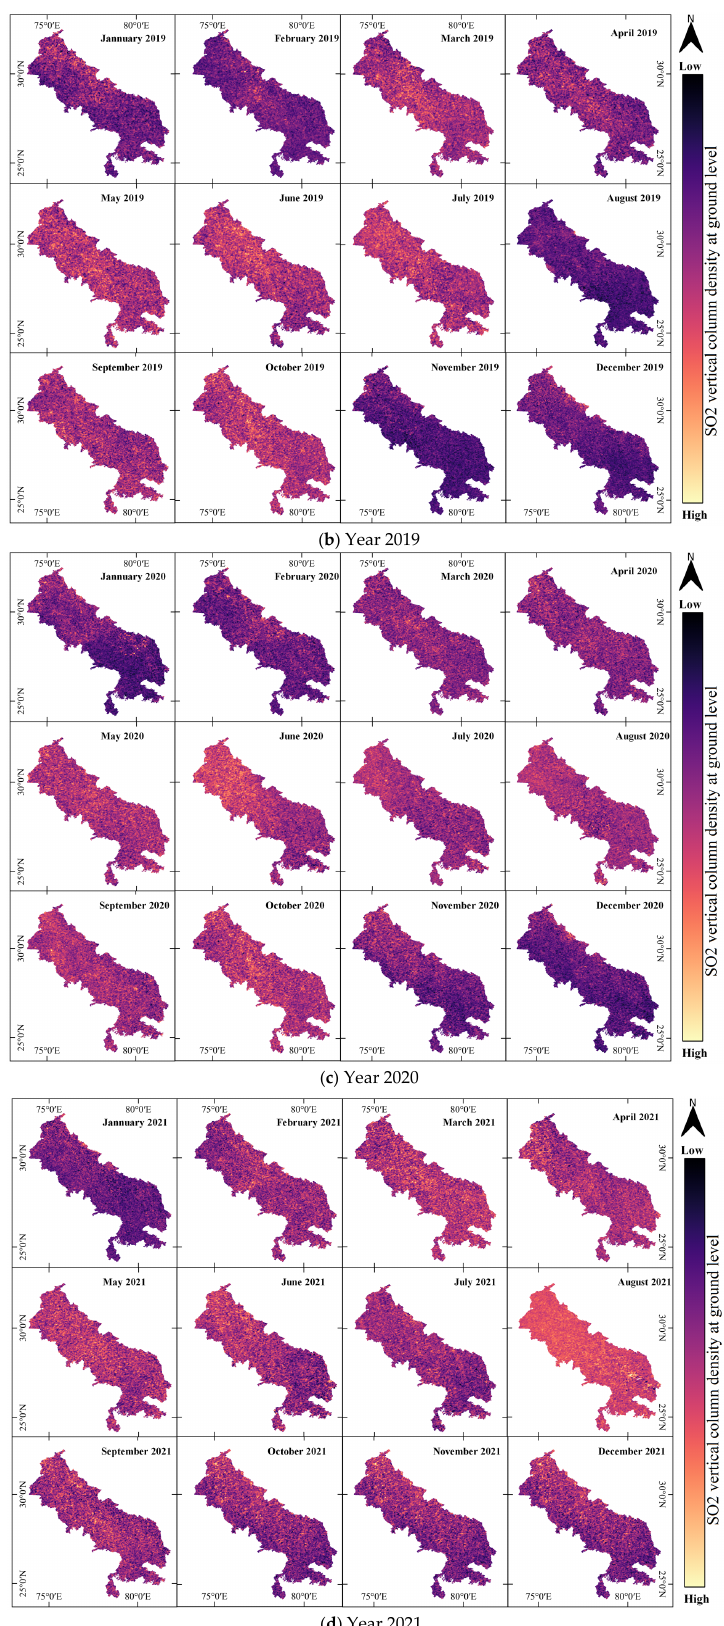
Figure 8. Atmospheric SO 2 concentration over the study site (December 2018 to December 2021).